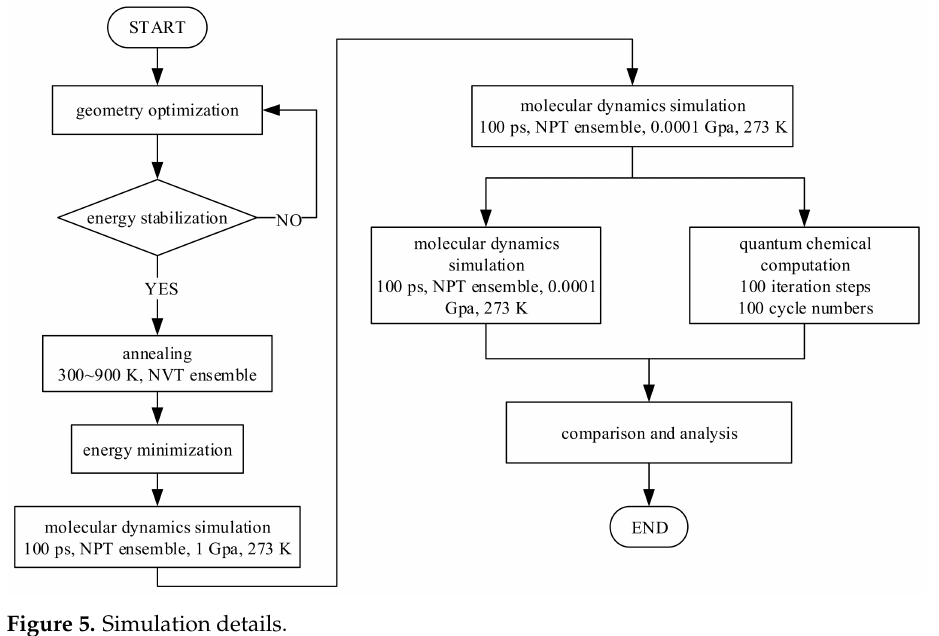
Figure 5. Simulation details.